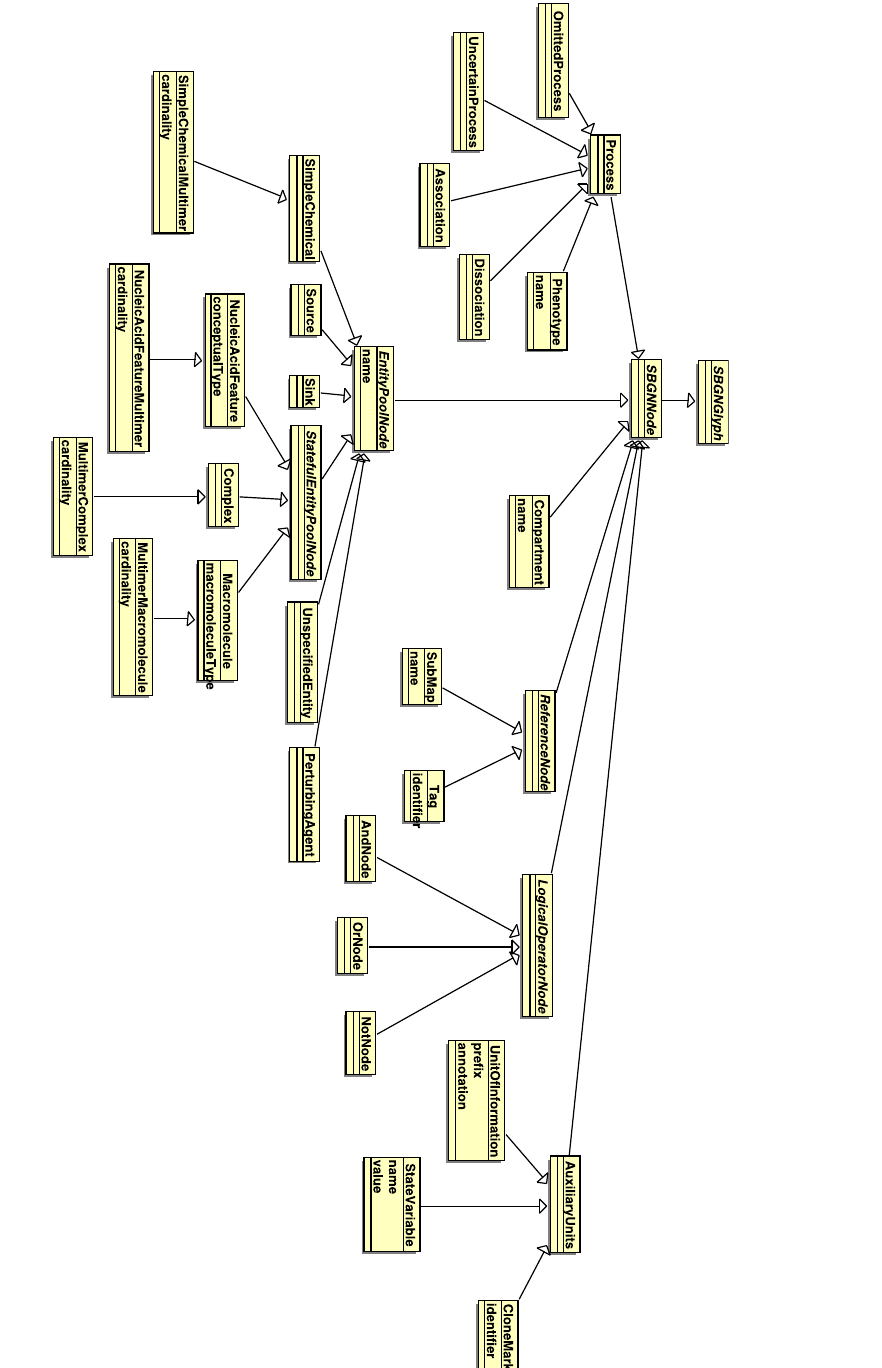
Figure 3.1: Organisation of the node glyphs within SBGN Process Description language. All UML classes (boxes) correspond to Process Description node glyphs except those with italicised names, which are organisational groupings. They correspond to the groupings used elsewhere in this